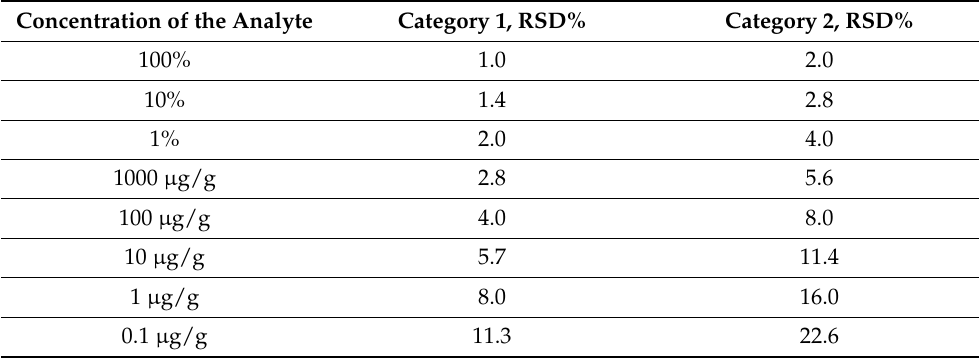
Table 2. The precisions (Relative Standard Deviation, %RSD) required for major, minor, and trace elements for different applications in geochemical studies, after